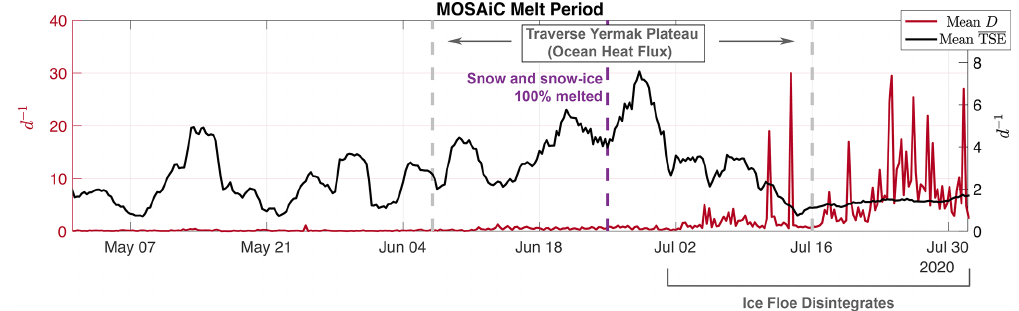
Figure 8. Average TSE and D during the MOSAiC melt period. A gradual increase in trajectory stretching is found until the onset of ice floe disintegration. Peak stretching was found immediately after all snow and snow ice was melted off the ice floe. Much larger TSE variance was found after a period of enhanced ocean heat flux as the ice floe crossed the Yermak Plateau. At this stage, the ice concentration dropped below 60%–85%, mean TSE values look flat from uncorrelated motions, and mean D spikes are an order of magnitude larger than when the ice floe remained